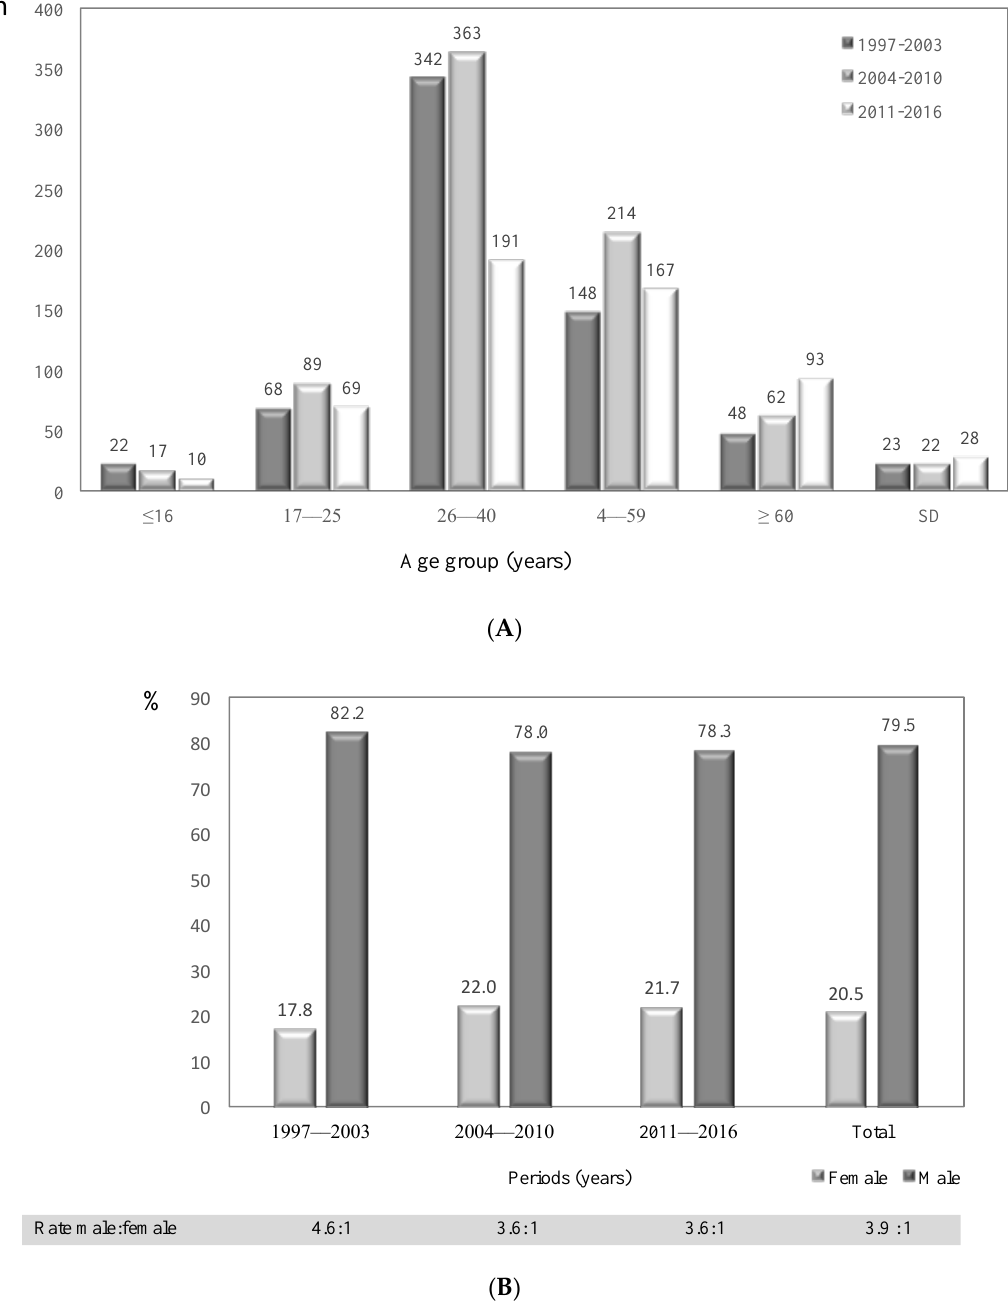
Figure 2. Number of patients with cryptococcosis in Colombia, 1997–2016. ( A ) Distribution by age group and study period. ( B ) Distribution by gender and study period.